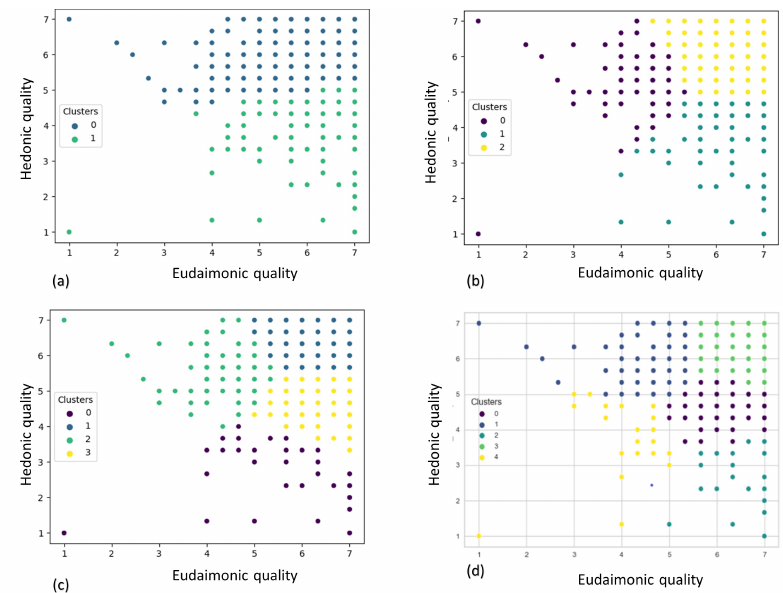
Figure 5. Different clusters formed by KMeans over eudaimonic and hedonic variables. ( a ): k = 2, ( b ): k = 3, ( c ): k = 4 and ( d ): k = 5. The parameter k of KMeans in scikit-learn library determines the number of